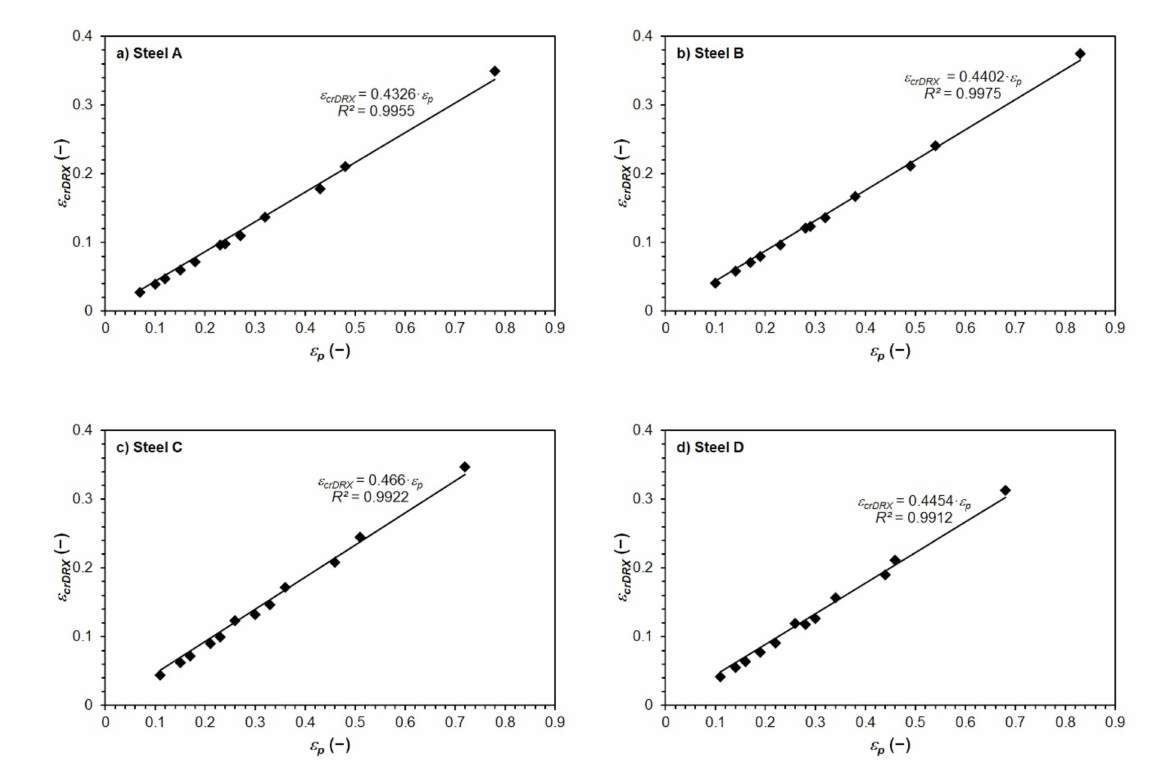
Figure 15. Relationship between critical strain ε crDRX and peak strain ε p of investigated steels: ( a ) steel